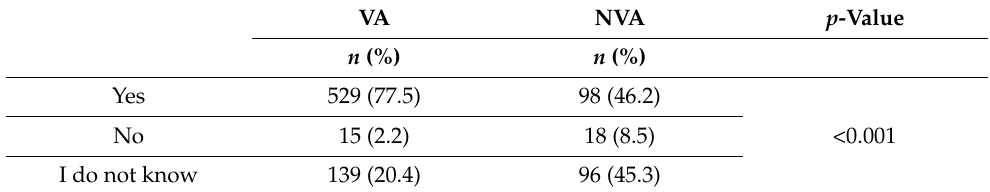
One in four athletes (25.8%, n = 231) stated that all of their teammates were vaccinated against COVID-19. Four in ten (41.2%, n = 369) stated that most of their teammates were vaccinated, and one in five (20.8%, n = 186) stated that about half of their teammates were vaccinated. One in ten (9.9%, n = 89) stated that only some of their teammates were vaccinated. Among VA athletes, more teammates were likely to be vaccinated than among NVA athletes (33.2% vs. 1.9%, respectively; p < 0.001) (Table 4). Table 4. Are your teammates vaccinated against COVID-19? Responses broken down by vaccinated (VA, n = 683) and unvaccinated (NVA, n = 212) against COVID-19.